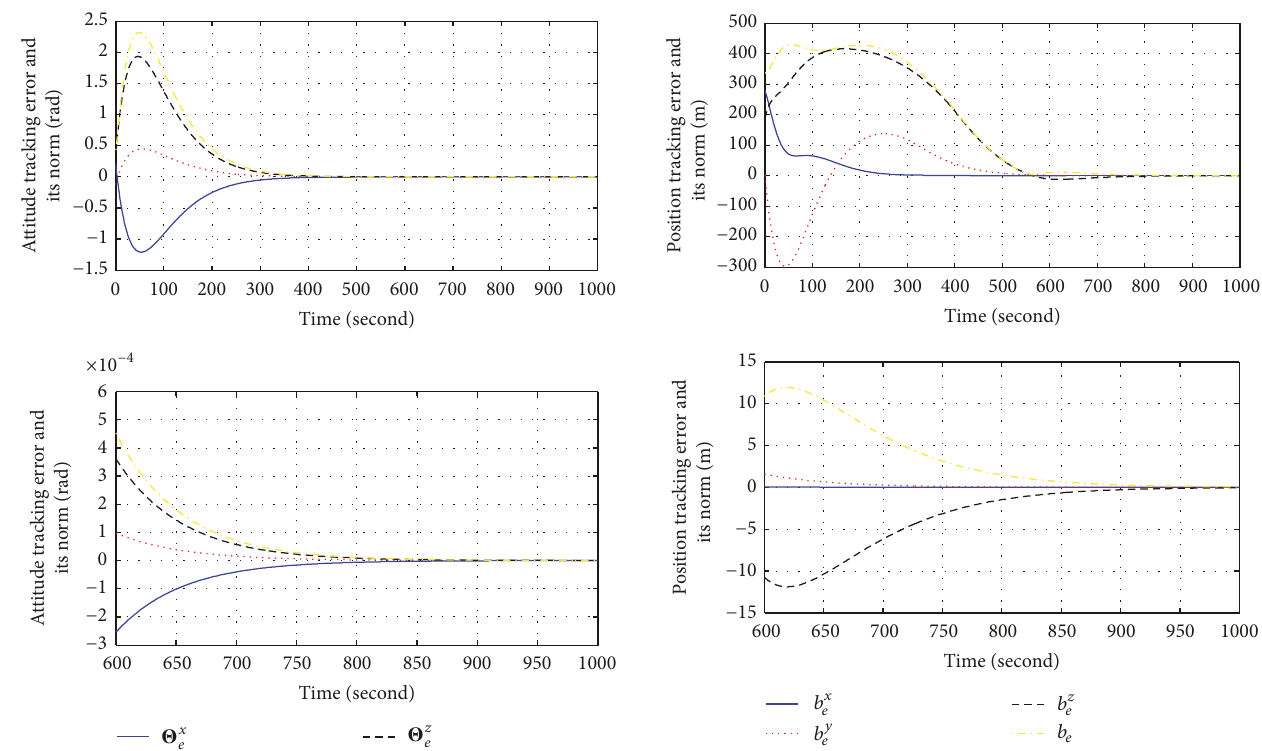
Figure 2: Exponential coordinates of attitude tracking error and its norm.